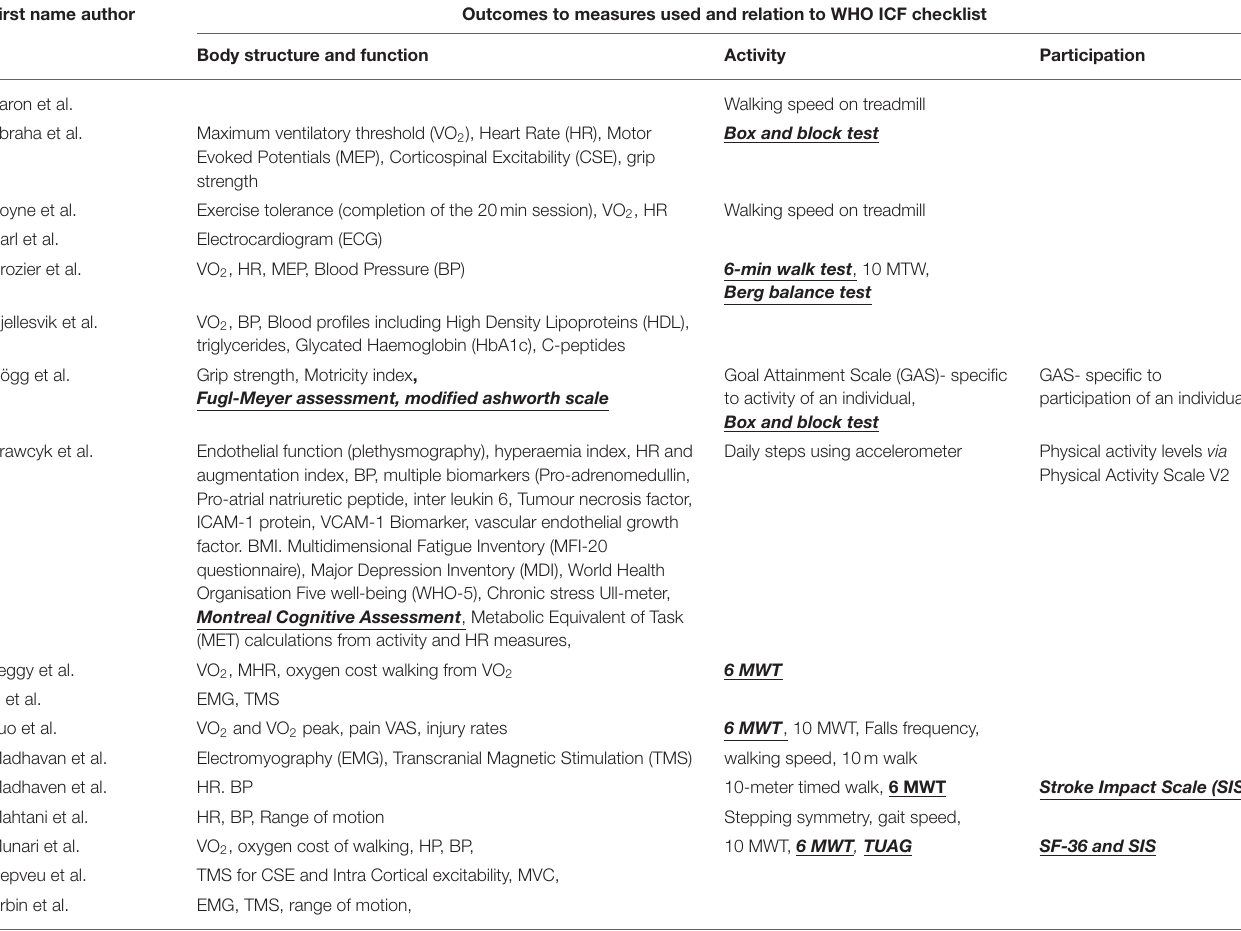
TABLE 4 | Outcomes measure linked to WHO international classification of functioning, disability, and health